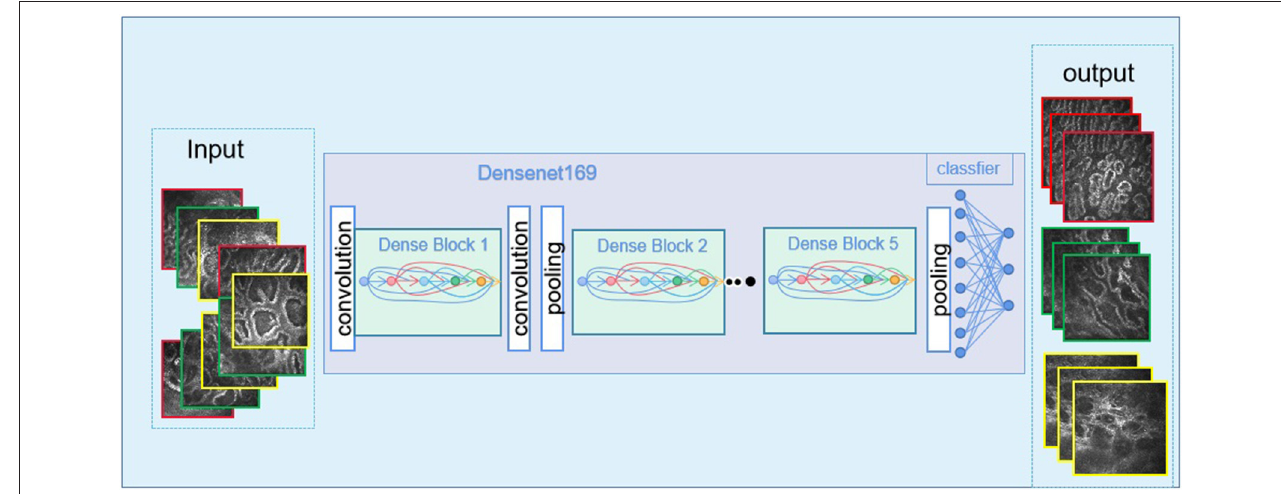
FIGURE 3 | The imaging images go through the deep learning algorithm and the output of the final results.